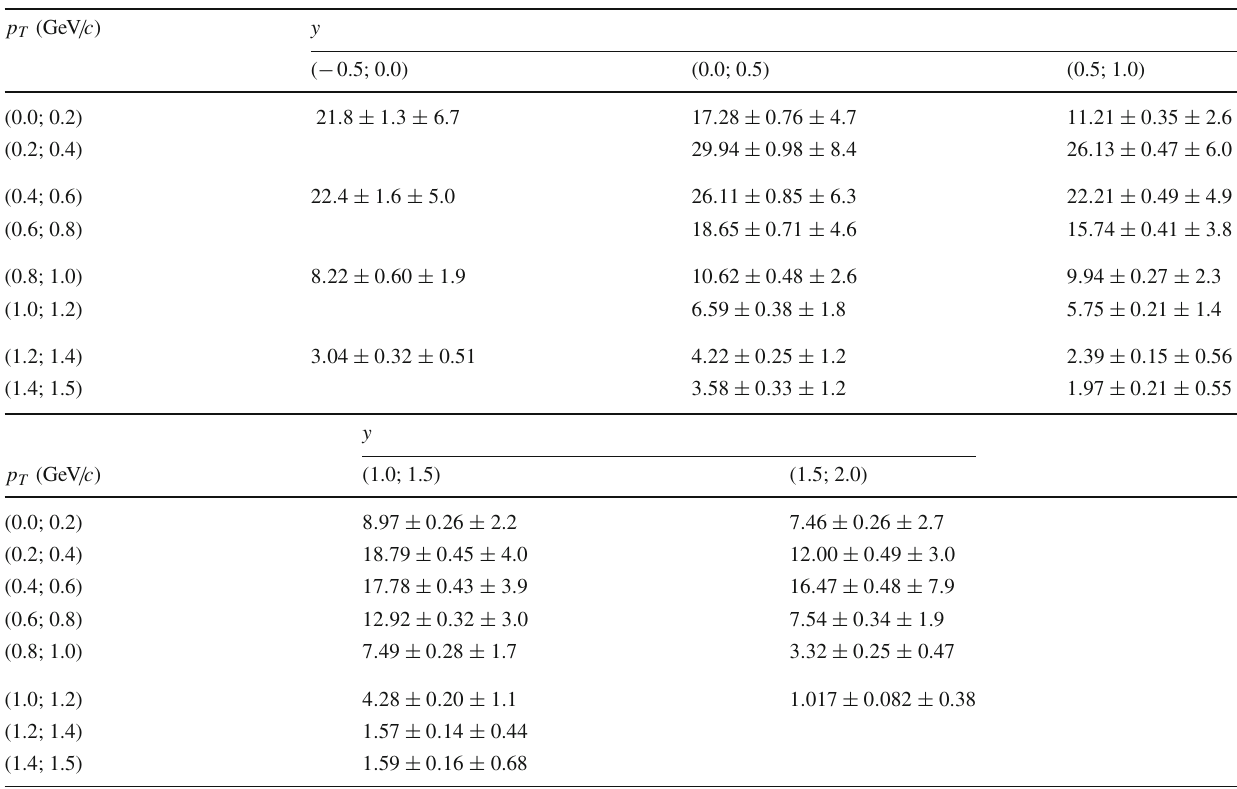
Table 3 Numerical values of double-differential yields d 2 n statistical, while the second one is